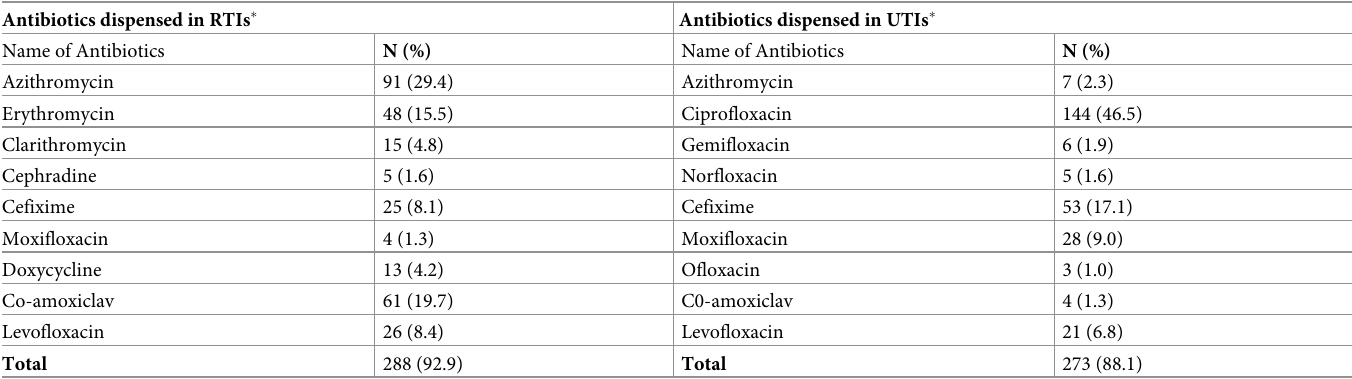
Table 2. Antibiotics dispensed without a prescription.